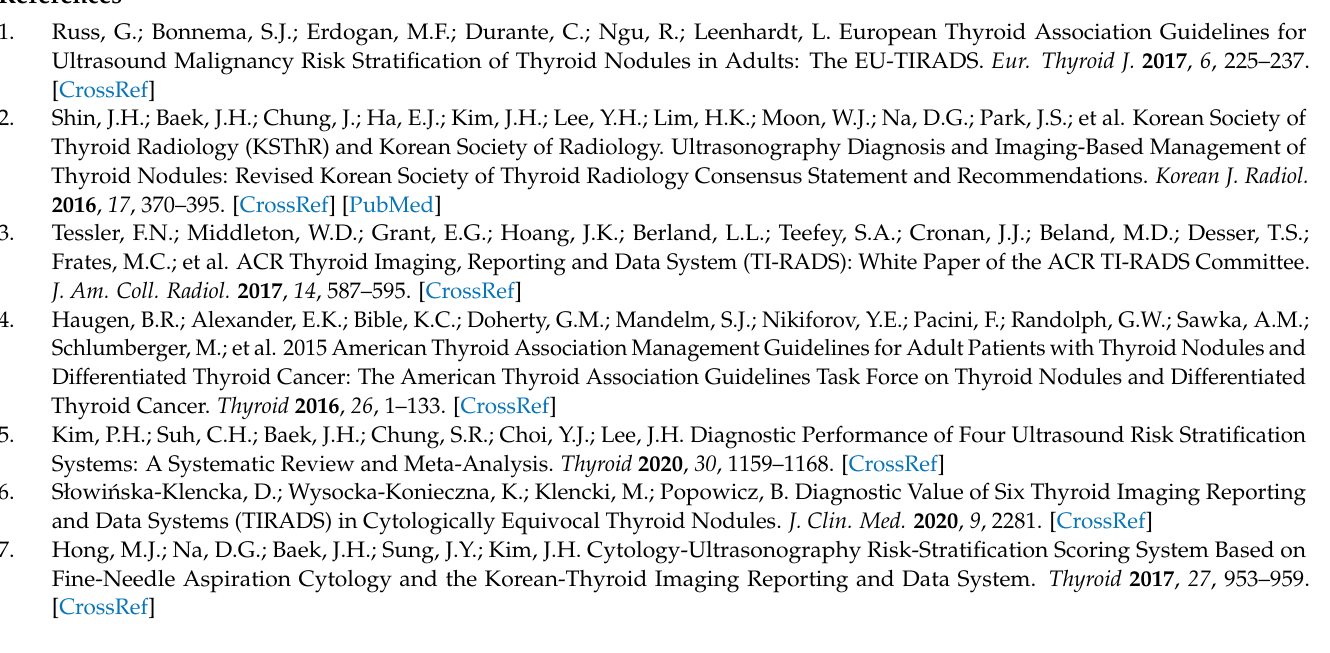
Supplementary Materials: The following are available online at https://www.mdpi.com/article/ 10.3390/cancers13194900/s1, Figure S1: ROC curve analysis of the evaluation of AP/T ratio on transverse plane in HT and non-HT groups; points of maximal ACC indicated on both curves, Figure S2: ROC curve analysis of the evaluation of AP/T ratio on longitudinal plane in HT and non- HT groups; points of maximal ACC indicated on both curves, Table S1: Incidence of round nodules (with anteroposterior diameter equal to transverse diameter) in HT and non-HT group, Table S2: Data on the diagnostic effectiveness of AP/T ratio evaluation in examined groups of nodules (HT and non-HT), with the threshold AP ≥ T or AP > T satisfied on any plane (transverse or longitudinal), Table S3: Data on the diagnostic effectiveness of AP/T ratio evaluation (on transverse plane) in examined groups of nodules (HT and non-HT), in relation to nodule’s size (largest diameter <1 cm and ≥ 1 cm), Table S4: Results of multivariate logistic regression analysis in HT and non-HT groups, Table S5: Influence of modifications of the threshold for suspicious nodule’s shape (from AP > T to AP ≥ T and AP/T ≥ 1.14 in HT group or AP/T ≥ 1.17 in non-HT group) on values of SEN, SPC, RoM and the percentage of nodules in the high risk category (changes expressed as percentage of values for AP > T